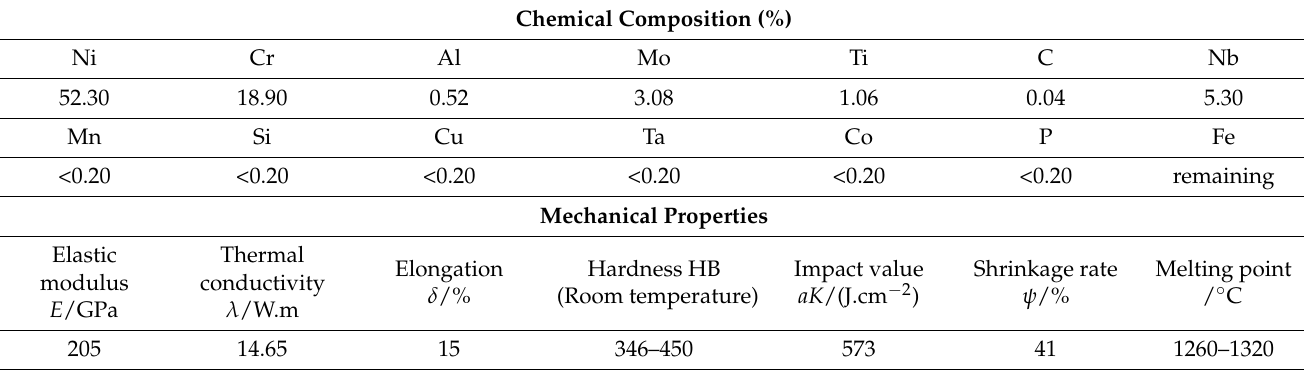
Table 3. Processing parameter selection table in the exploratory experiment.